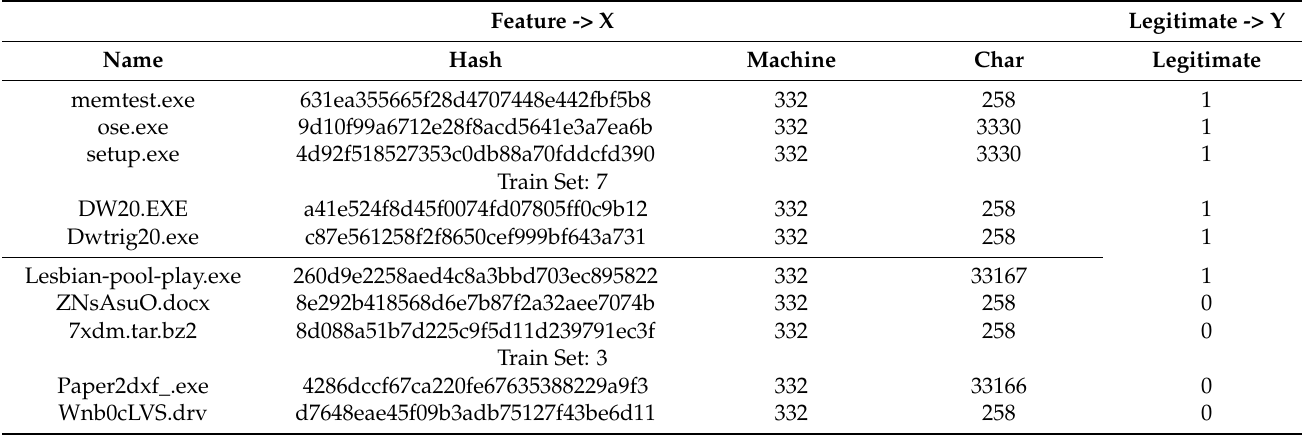
Table 4. Training and test split results.